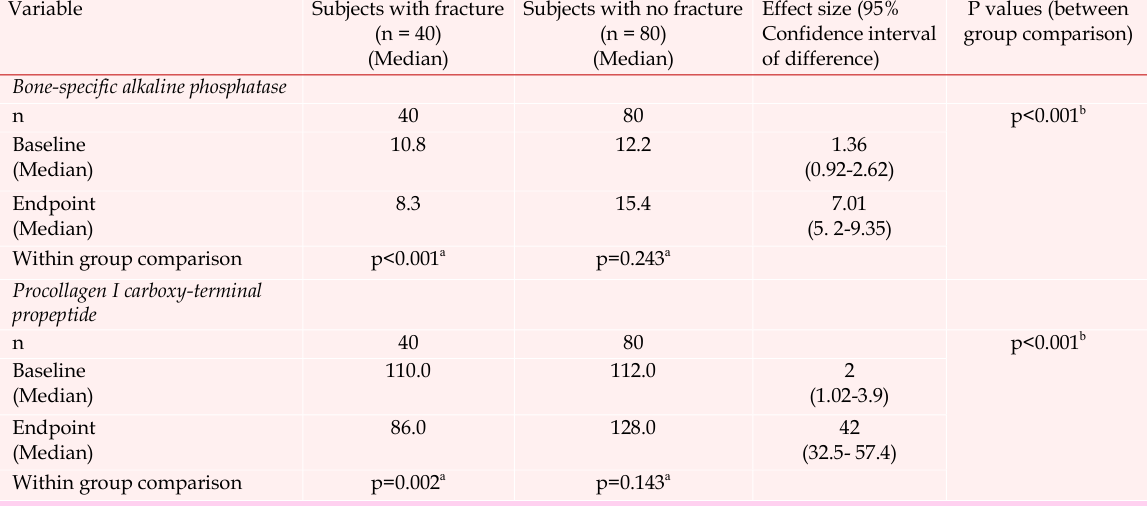
Percentage change in bone-specific alkaline phosphatase (ug/L) and procollagen I